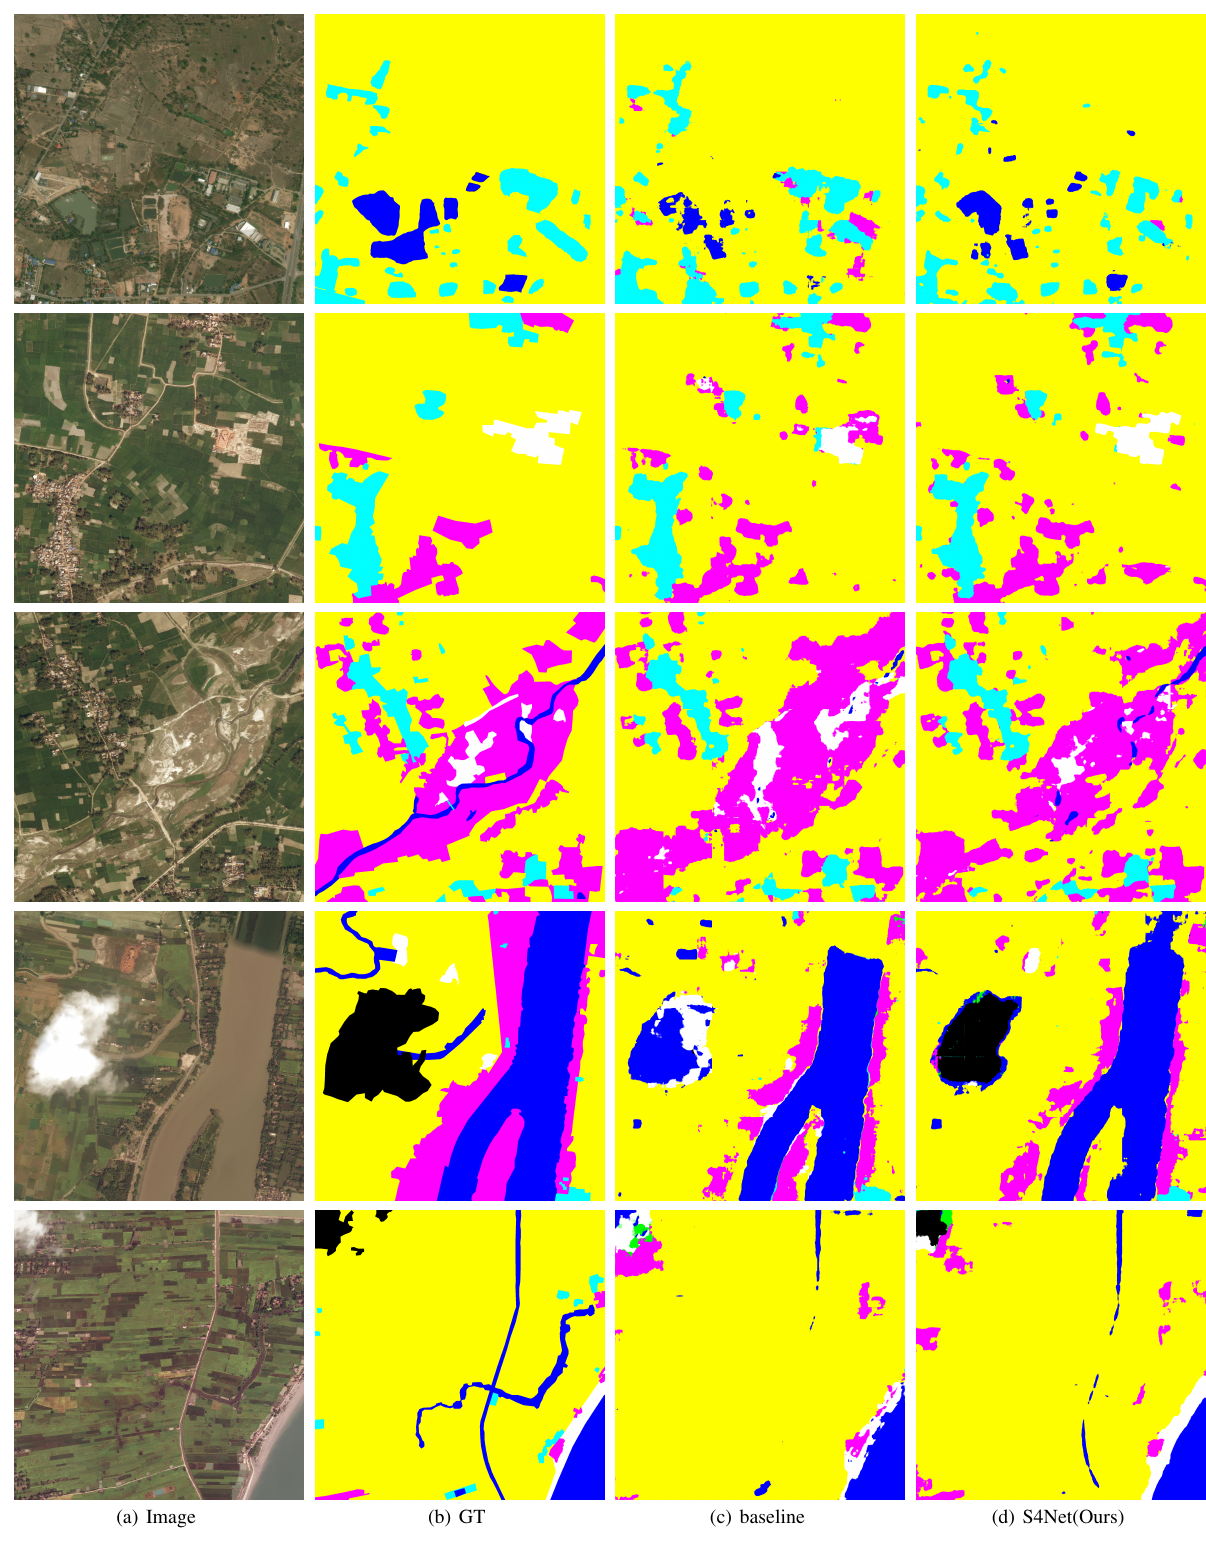
Figure 4. The results of the baseline method and our